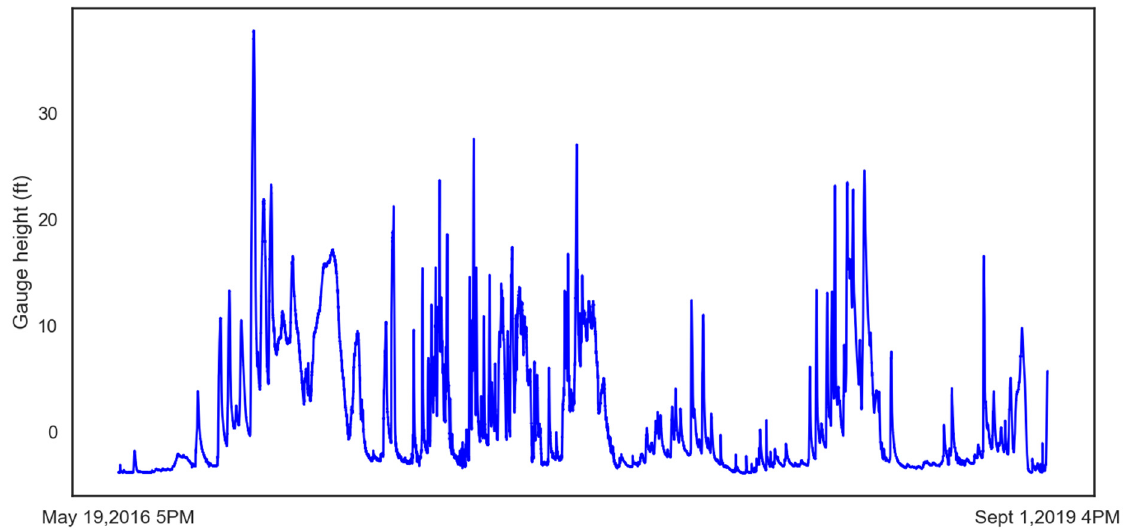
Figure 4. Gauge height data used for training and testing .